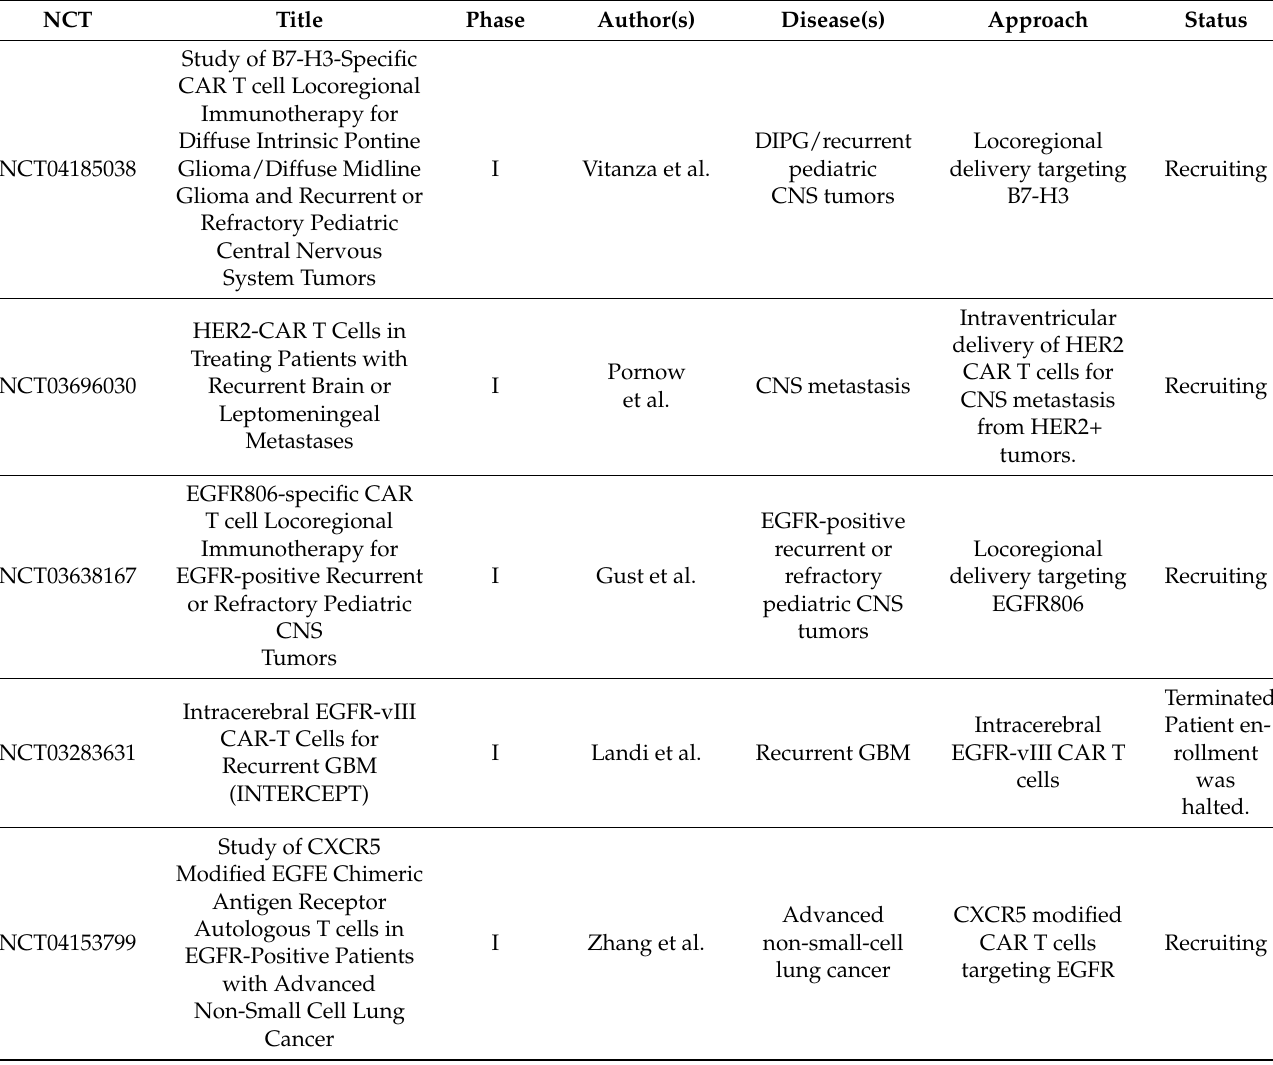
Table 2. Human clinical trials with strategies to enhance CAR T